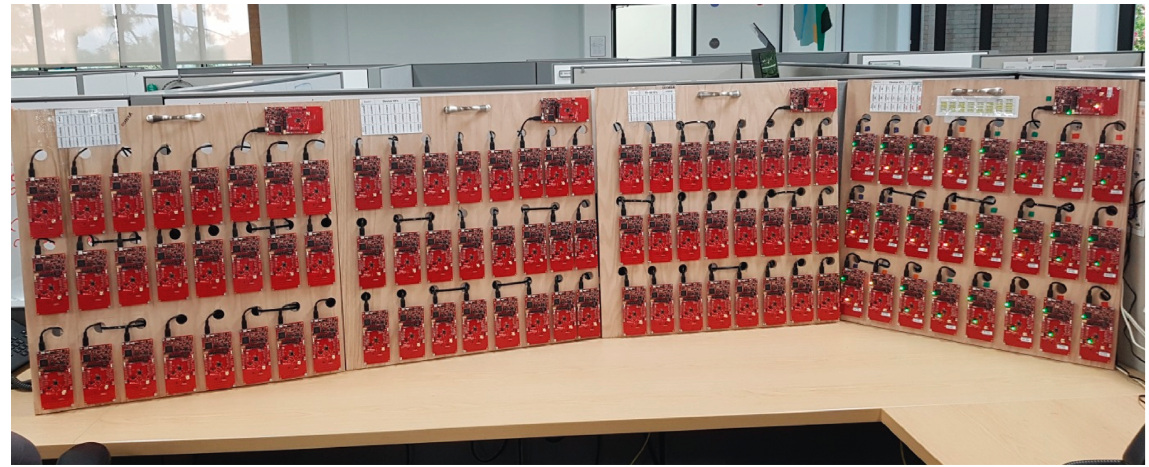
Figure 18: 100-node network